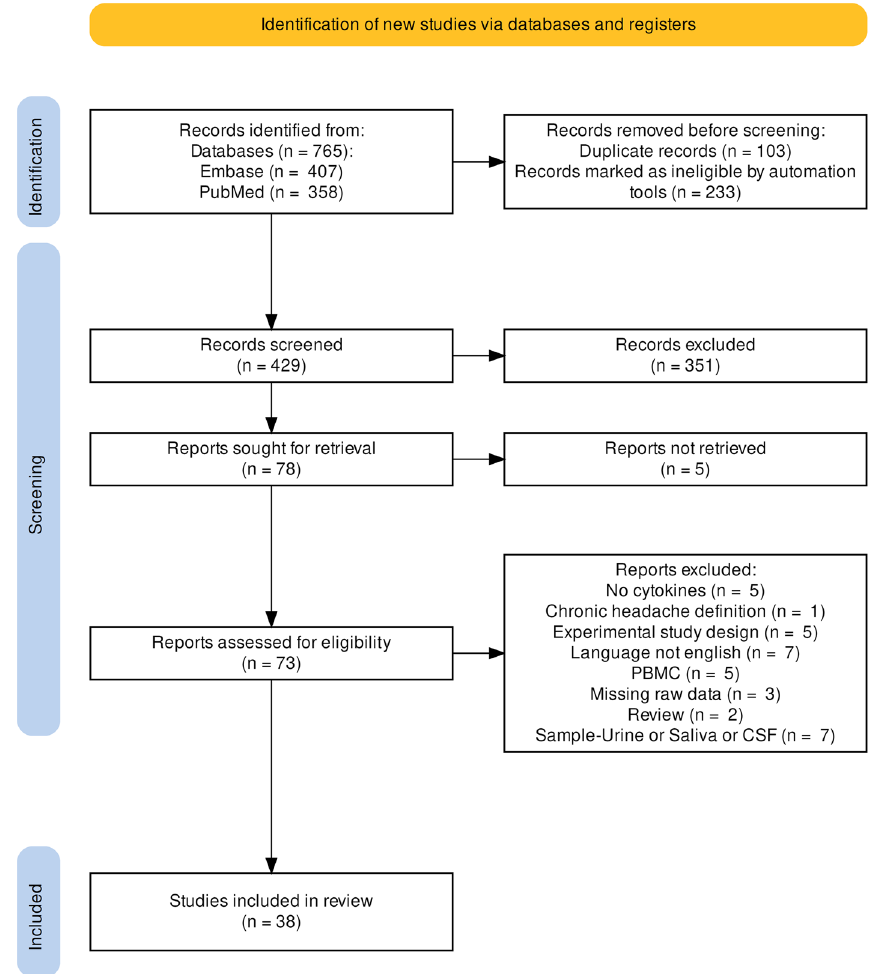
Fig. 1 PRISMA flow diagram of study selection. Abbreviations: PMBC, studies measuring cytokine production by peripheral blood mononuclear cells in vitro, rather than circulating serum